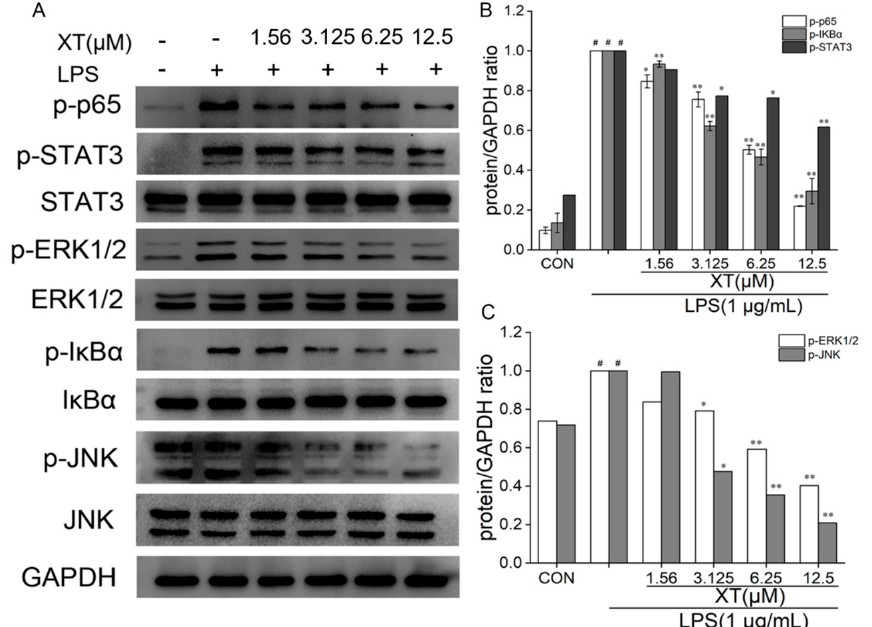
Figure 7. Effects of xanthatin on NF- κ B, MAPK and STATs ( A ) protein expression in LPS-induced RAW 264.7 cells. The relative expression grey value of each protein band is shown ( B , C ). GAPDH was considered as an internal reference. #: significantly different compared to the control (CON) group, *: p < 0.05, **: p < 0.01, as compared to the LPS-induced group.